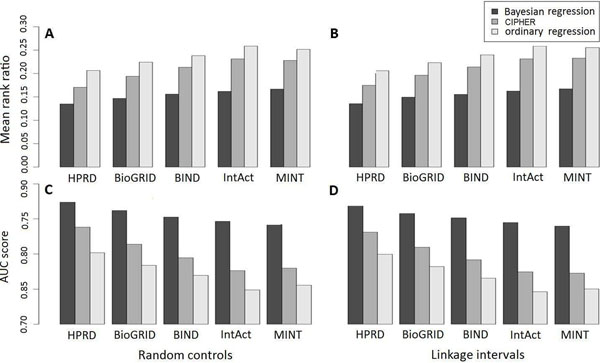
Comparison with the CIPHER approach and the ordinary regression method. Subplots A and C illustrate mean rank ratios and AUC scores against random controls, respectively. Subplots B and D illustrate mean rank ratios and AUC scores against linkage intervals, respectively. Results for the validation of random controls are average of 10 independent runs (Variance not shown).